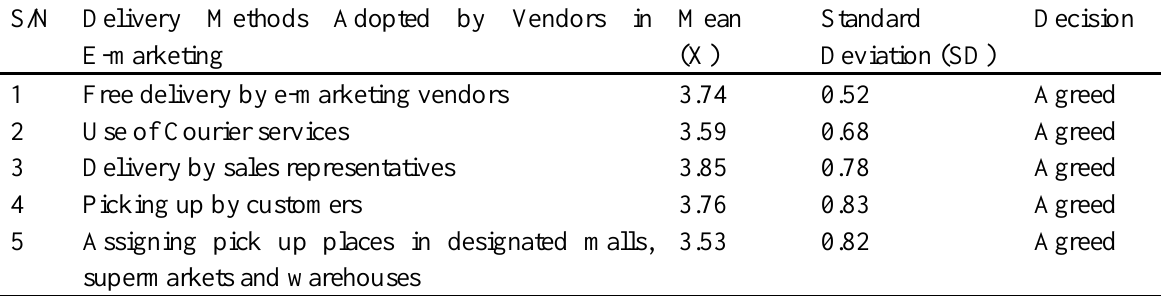
Table 2: Mean Rating and Standard Deviation Responses of the Delivery Methods Adopted by Vendors in E-marketing